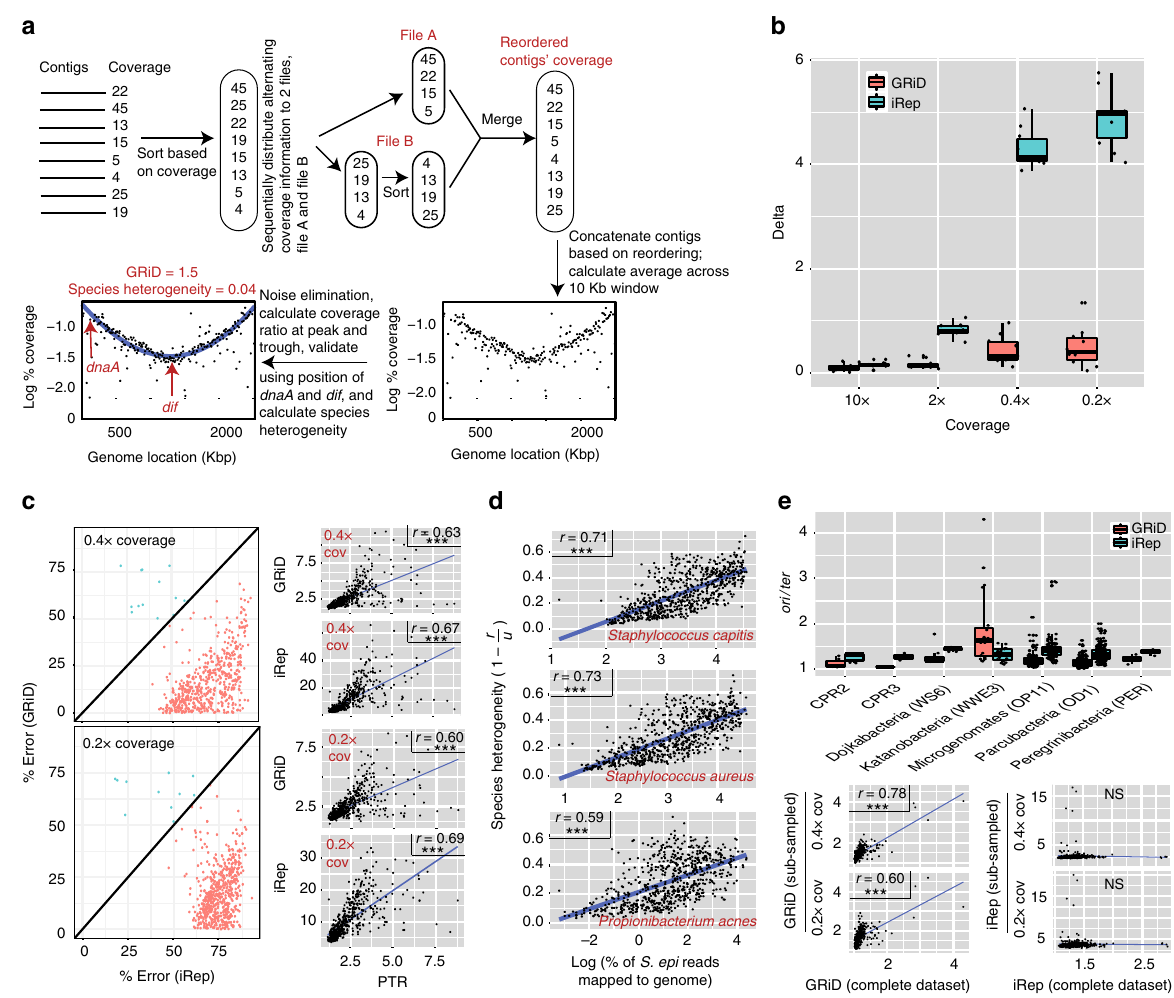
Fig. 1 In situ growth estimate from ultra-low coverage bacteria. a The GRiD approach. Contigs are re-ordered to produce a pattern whereby low coverage contigs potentially containing ter are located near the mid-region of the genome, while high-coverage contigs potentially harboring ori are located at either extremes of the genome. GRiD values correspond to the ratio of coverage at the peak ( ori ) and trough ( ter ) regions. b Growth rate reproducibility between GRiD and iRep using reads obtained from pure cultures of Staphylococcus epidermidis and Corynebacterium simulans . The boxplot shows the difference (delta) in growth estimates before and after reads were subsampled to lower coverage. To avoid bias, only unre fi ned GRiD values (see methods) were used for comparison with iRep. c Error rate comparison between GRiD and iRep from a skin metagenomic dataset using S. epidermidis reference genome. PTR was calculated using a closed circular reference genome while GRiD and iRep were calculated using the same reference genome, but fragmented into 100kb fragments and reshuf fl ed. For samples with genome coverage > 0.2 ( n = 588), mapped reads were subsampled to ultra-low coverage prior to GRiD and ´ 100, where “ predicted ” represent GRiD or iRep scores, and “ real ” is the PTR score. iRep estimations. Here, Percenterror ¼ ð max ð predicted ; real ÞÞ(cid:2)ð min ð predicted ; real ÞÞ ð max ð predicted ; real ÞÞ Unre fi ned GRiD values were used for comparison with iRep. The fi gure on the right shows Pearson correlation plots of GRiD and iRep with PTR. *** = p < 0.001. d Reads from a skin metagenomic dataset mapping to S. epidermidis were remapped to the respective genomes. Re-mapped reads are considered as ambiguous reads. The scatter plot shows the correlation (Spearman) between ambiguous reads and species heterogeneity (1 − r / u ), where r = re fi ned GRiD and u = unre fi ned GRiD (see Methods). *** = p < 0.001. e iRep and GRiD measurement for CPR genomes. The scatter plots below show Pearson correlation plots of GRiD and iRep estimates before and after subsampling to ultra-low coverage. *** = p < 0.001. Center lines in boxplots represent the median and the edges represent the fi rst and third quartiles. Source data are provided as a Source Data fi le